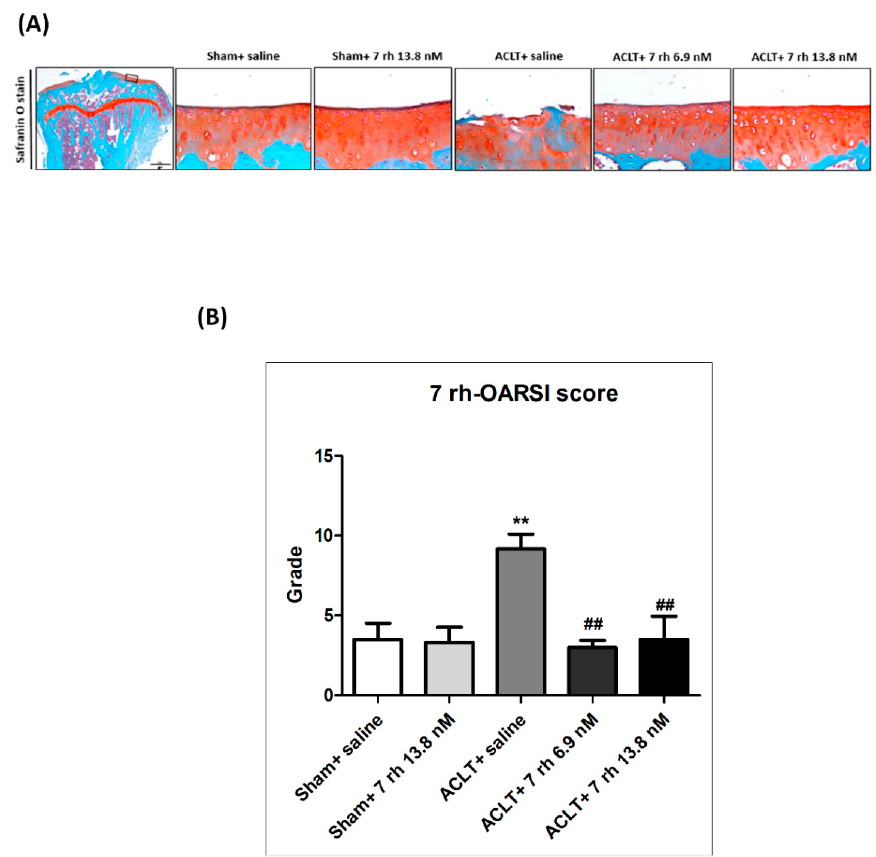
Figure 3. Intra-articular injection of 7 rh attenuated cartilage degradation in anterior cruciate ligament transection (ACLT)-induced osteoarthritis (OA). ( A ) The representative Safranin O-Fast Green stained articular cartilages micrographs of the proximal tibia from the right knee joints of mice in the sham control groups ( sham+ saline and sham+ 7 rh 13.8 nM ) , ACLT, and two 7 rh treated groups. ( B ) Osteoarthritis Research Society International (OARSI) scores of articular cartilage at 5 weeks after ACLT surgery. (** p < 0.01 versus the sham control groups; ## p < 0.01 versus the ACLT group). 2.4. The IA Administration of 7 rh Decreases the Expression of Hypertrophic Markers (Col X, MMP13, and IHH) after OA Induction